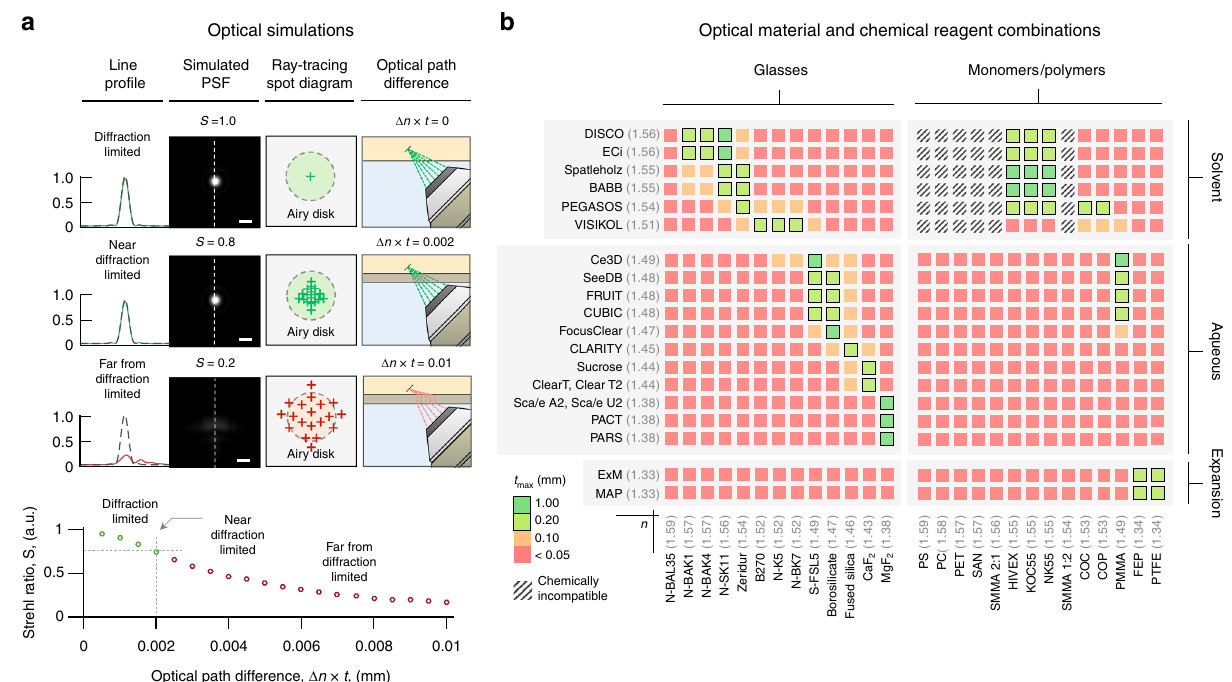
Fig. 2 Holder design for OTLS imaging. a Optical simulations of the system ’ s point spread function (PSF) and Strehl ratio ( S ), and ray-tracing spot diagrams, are shown for scenarios in which the optical path difference ( Δ n × t ) is negligible, small, or large, which results in diffraction-limited ( S ~ 1.0), near- diffraction-limited ( S > 0.8), or aberrated ( S < 0.8) imaging performance, respectively (scale bars: 1 μ m). The dependence of the Strehl Ratio, S , as a function of Δ n × t is plotted, indicating that for diffraction-limited imaging, the condition that Δ n × t < 0.002 mm should be maintained. Based on this condition, potential glass and monomer/polymer holder materials are shown in ( b ). The color scale indicates the maximum material thickness, t max , that is allowed based upon the intrinsic mismatch, Δ n , of those materials with published clearing protocols. Chemically incompatible combinations of materials and chemical reagents are also